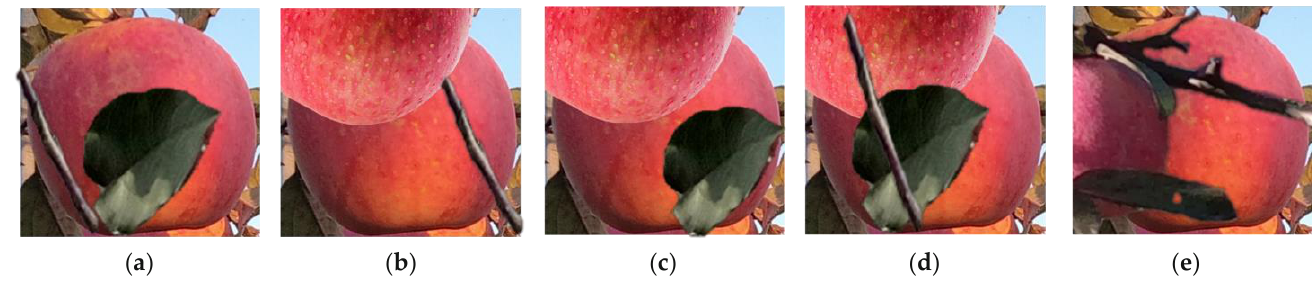
Figure 8. Synthesis results of fused occlusion apple: ( a ) Synthetic BL image; ( b ) Synthetic BF image;